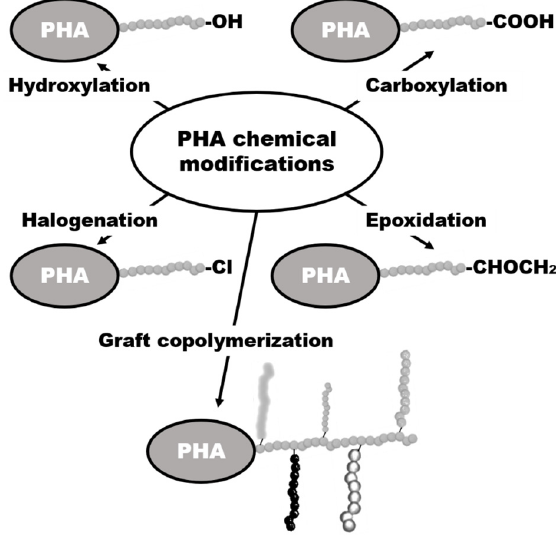
Figure 2. PHA chemical modifications.